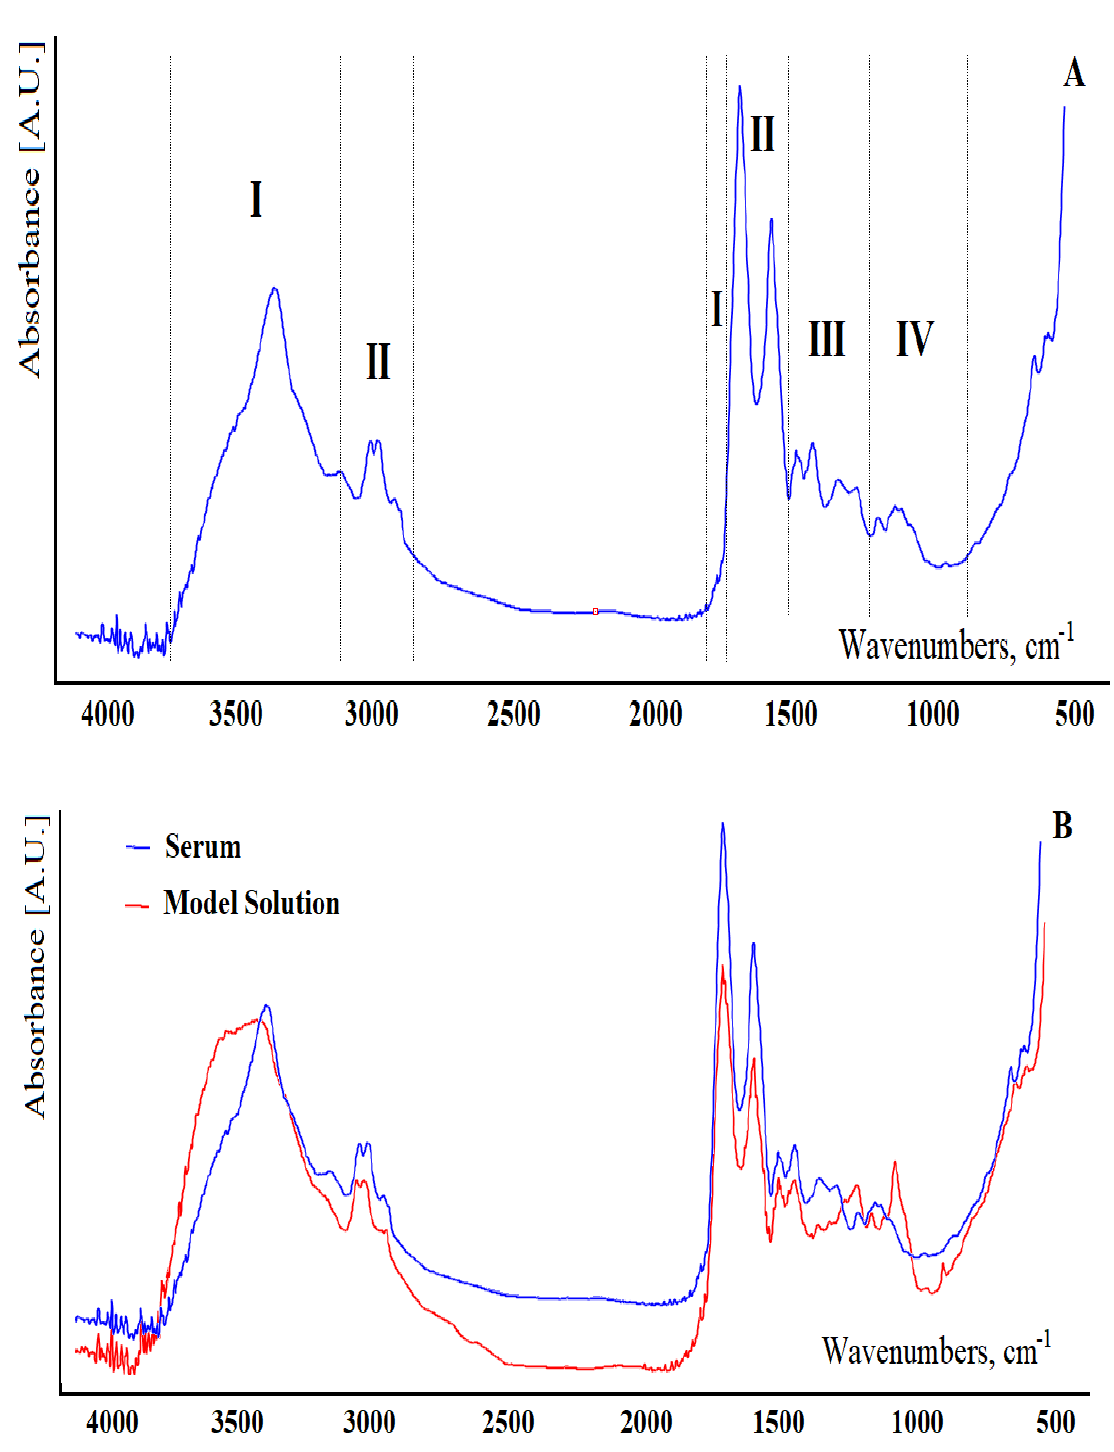
Figure 1. FTIR spectra of the serum ( A ) and model solution ( B ). Region I—absorption of proteins (3400–3030 cm − 1 , 1720–1480 cm − 1 , and 1301–1229 cm − 1 ); region II—lipid absorption (3020–2819 cm − 1 , 1750–1725 cm − 1 and 1480–1430 cm − 1 ); region III—absorption of carbohydrates and nucleic acids (DNA/RNA) in the range 1200–900 cm − 1 ; region IV—vibrations of some functional groups of proteins and lipids.